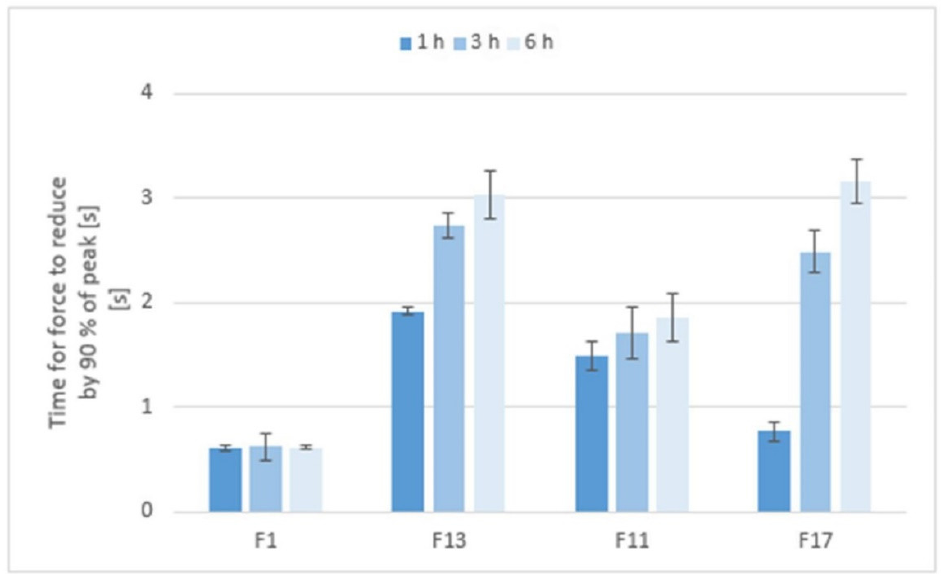
Figure 12. The adhesion time of matrix tablets to a model mucin substrate during an in vitro tensile test.